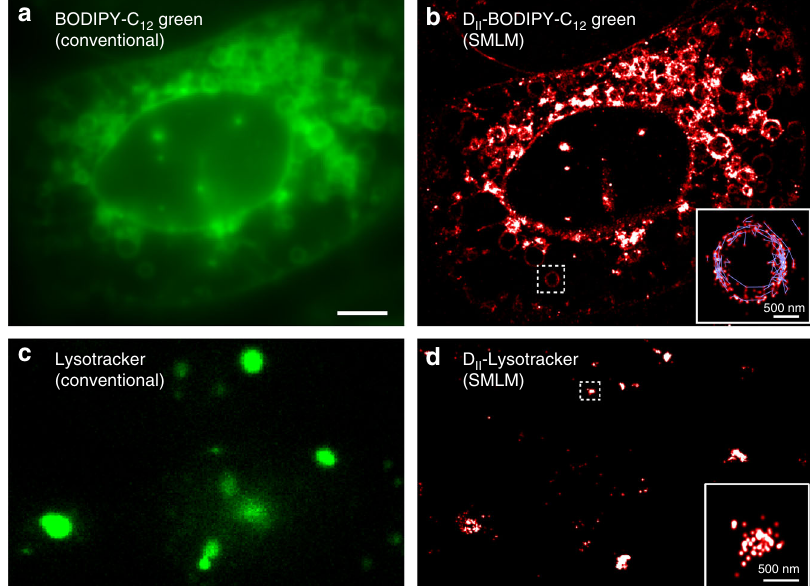
Fig. 6 SMLM and tracking of fatty acid analogs and LysoTracker Green using D II -states in living mammalian cells. a Conventional fl uorescence image of BODIPY-C 12 in U2OS cells. LDs of various sizes become visible and are generally bigger compared to yeast. b Super-resolution microscopy image of D II states of BODIPY-C 12 . Zoom: Superposition of single-molecule localizations (red) and traces (blue) reveal the motion of fatty acid analogs along the periphery of LDs. c Conventional fl uorescence image of LysoTracker Green with 488 nm excitation. d SMLM images of D II states of LTG with 561 nm excitation. Zoom : SMLM image of an immobile lysosome. Scale bar: 5 µ m; insets: 500